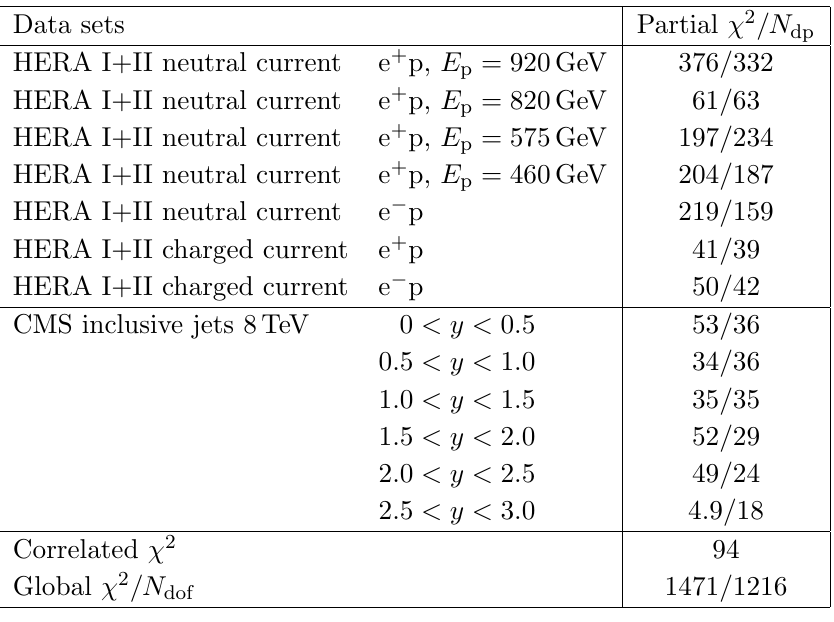
Table 7 . Partial (cid:31) 2 =N dp per number of data points N dp and the global (cid:31) 2 per degree of freedom, N dof , as obtained in the QCD analysis of HERA DIS data and the CMS measurements of inclusive p jet production at s = 8 TeV.